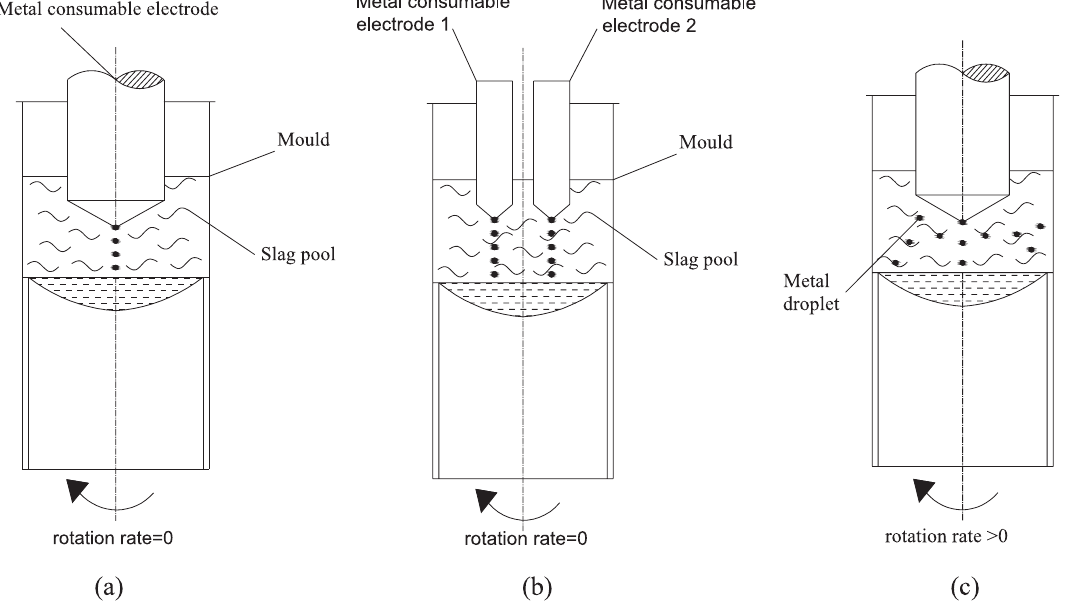
Fig. 9: Schematic of traditional ESR (a, b) and mould rotation ESR